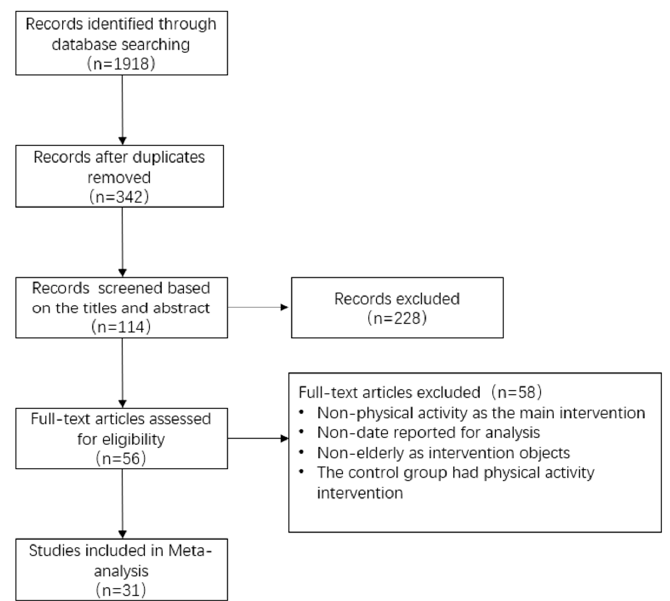
Figure 1. Literature selection process.